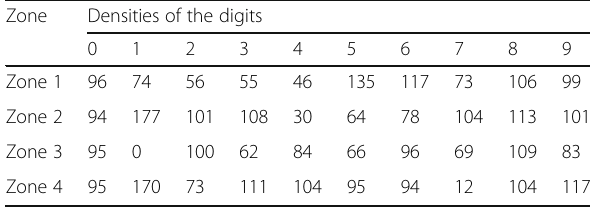
Table 2 Zone densities for ideal resized bordered characters